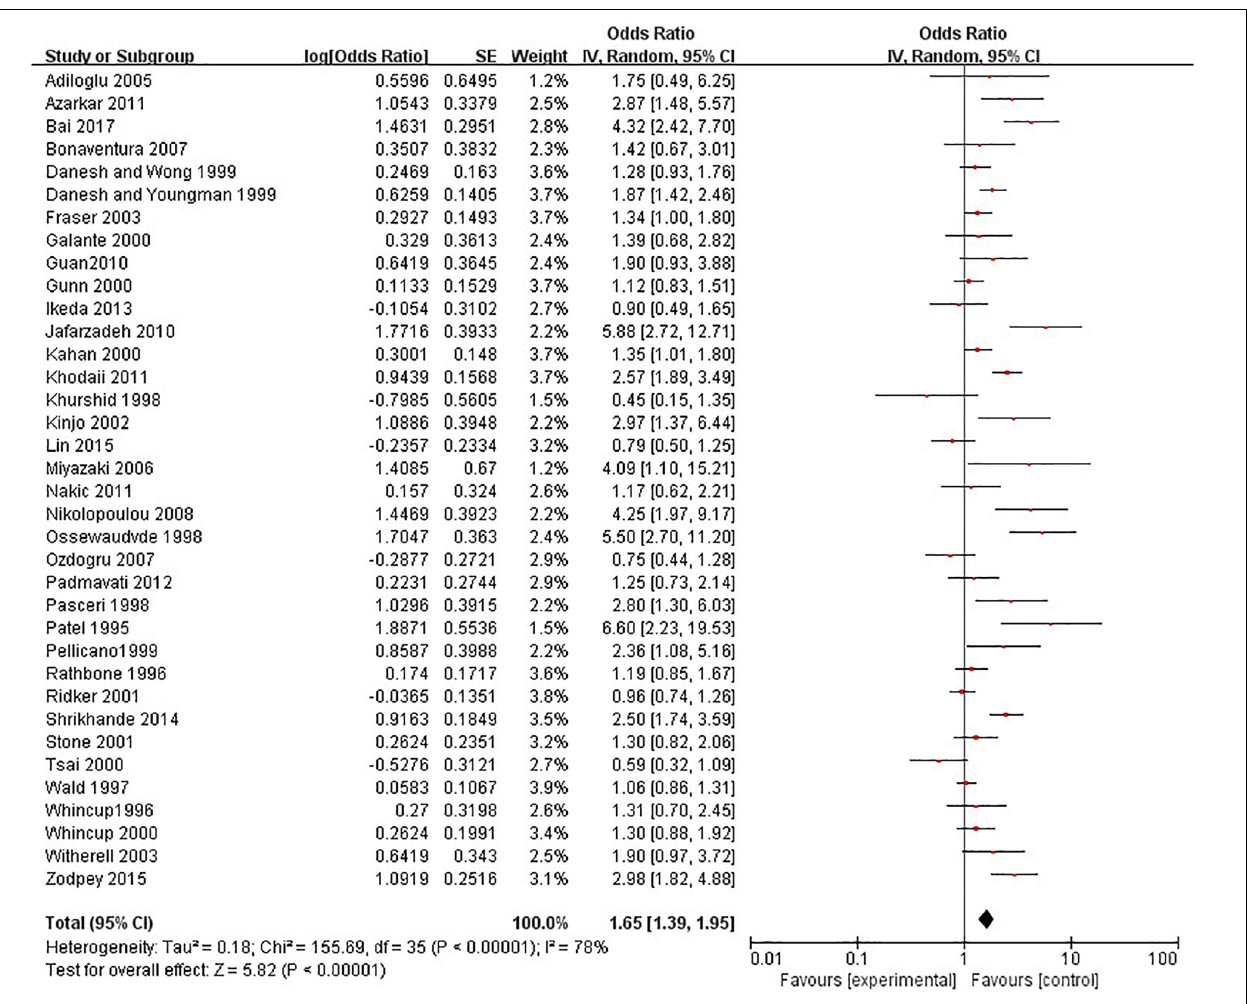
FIGURE 3 | Relationship anti- H. pylori IgG test and CHD in studies reporting odds ratio (OR).